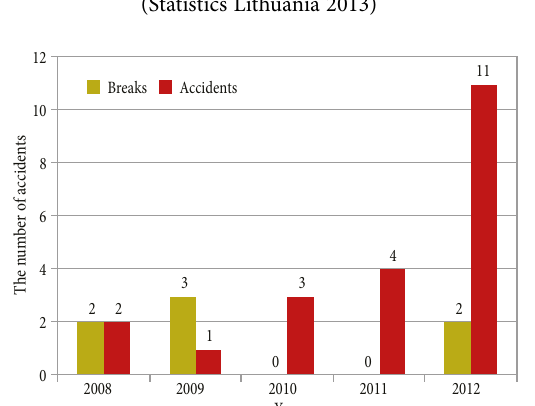
Fig. 2. The number of incidents in railway transport